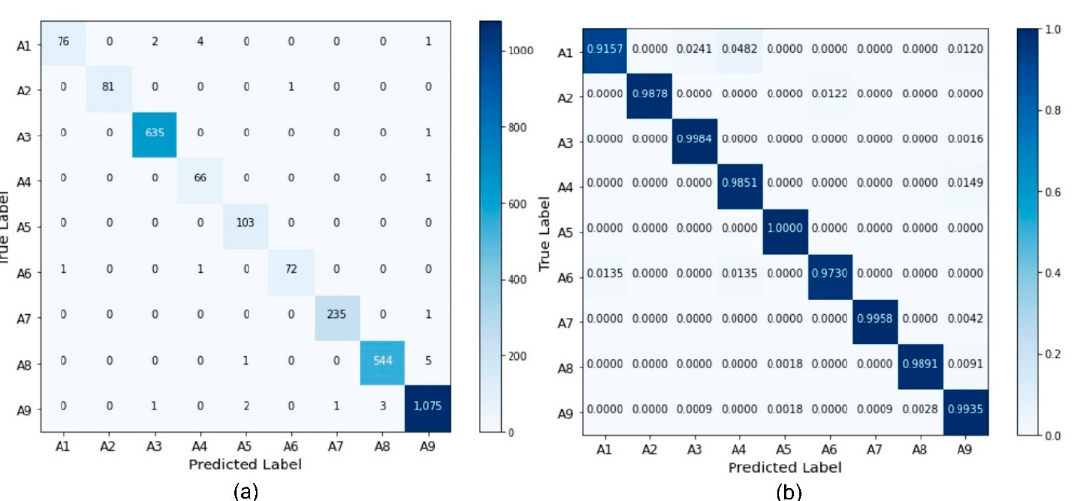
Figure 11. Confusion matrix: ( a ) unnormalized; ( b ) normalized.